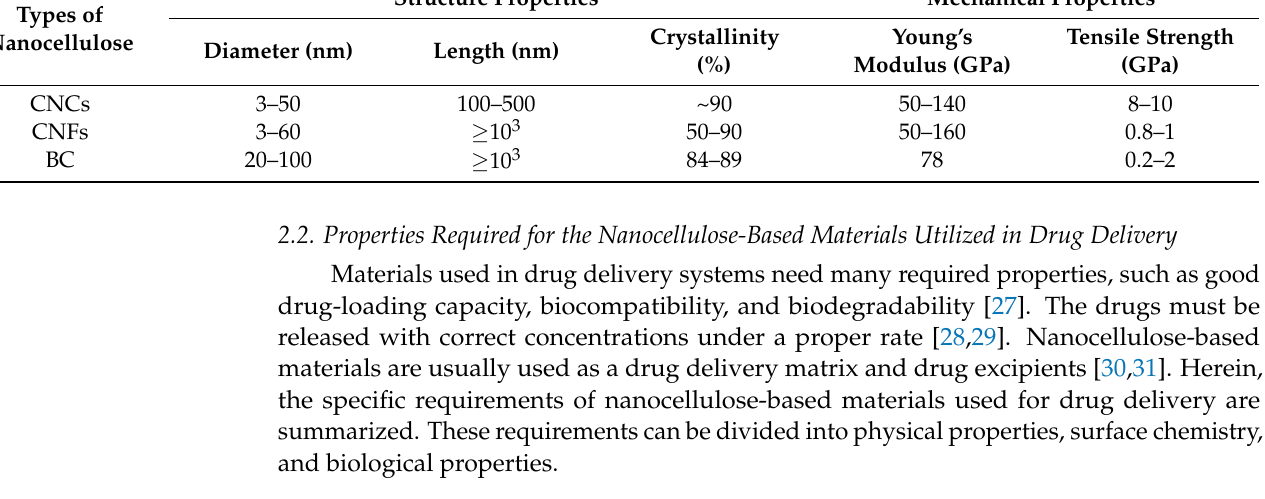
Table 1. Comparison of structure parameters of different types of nanocellulose. Structure Properties Mechanical Types of Nanocellulose